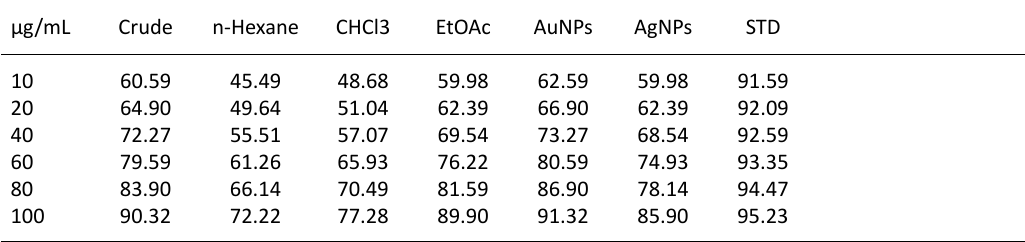
Table 2. FTIR analysis of crude extract of D.salicifolia Wave number Functional Vibration Intensity Table 3. Antioxidant activity (% DPPH. activity) of the crude extract, fractions and nanoparticles of D. salicifolia µg/mL Crude